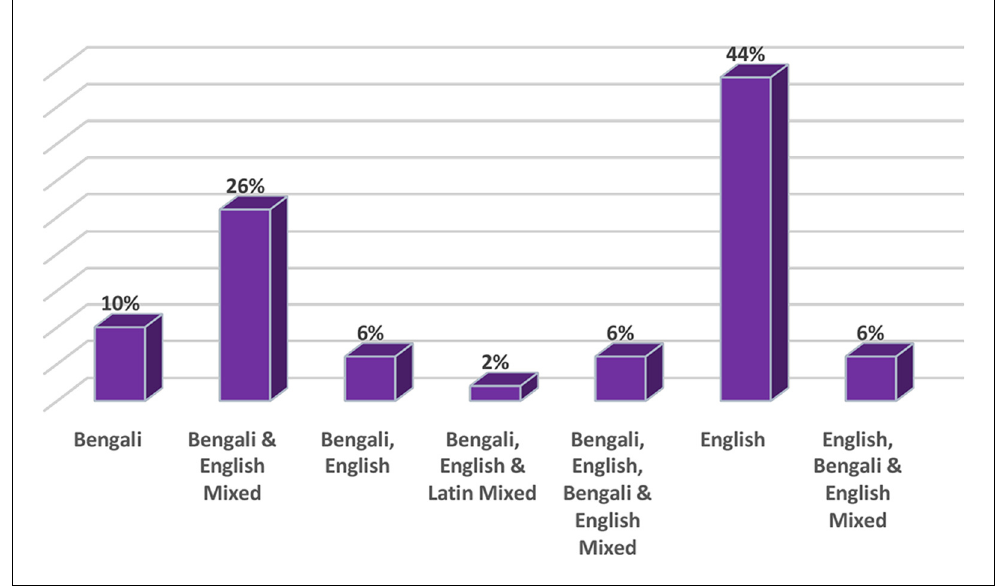
Figure 2. Proportion of prescriptions using each language or mix of languages, according to